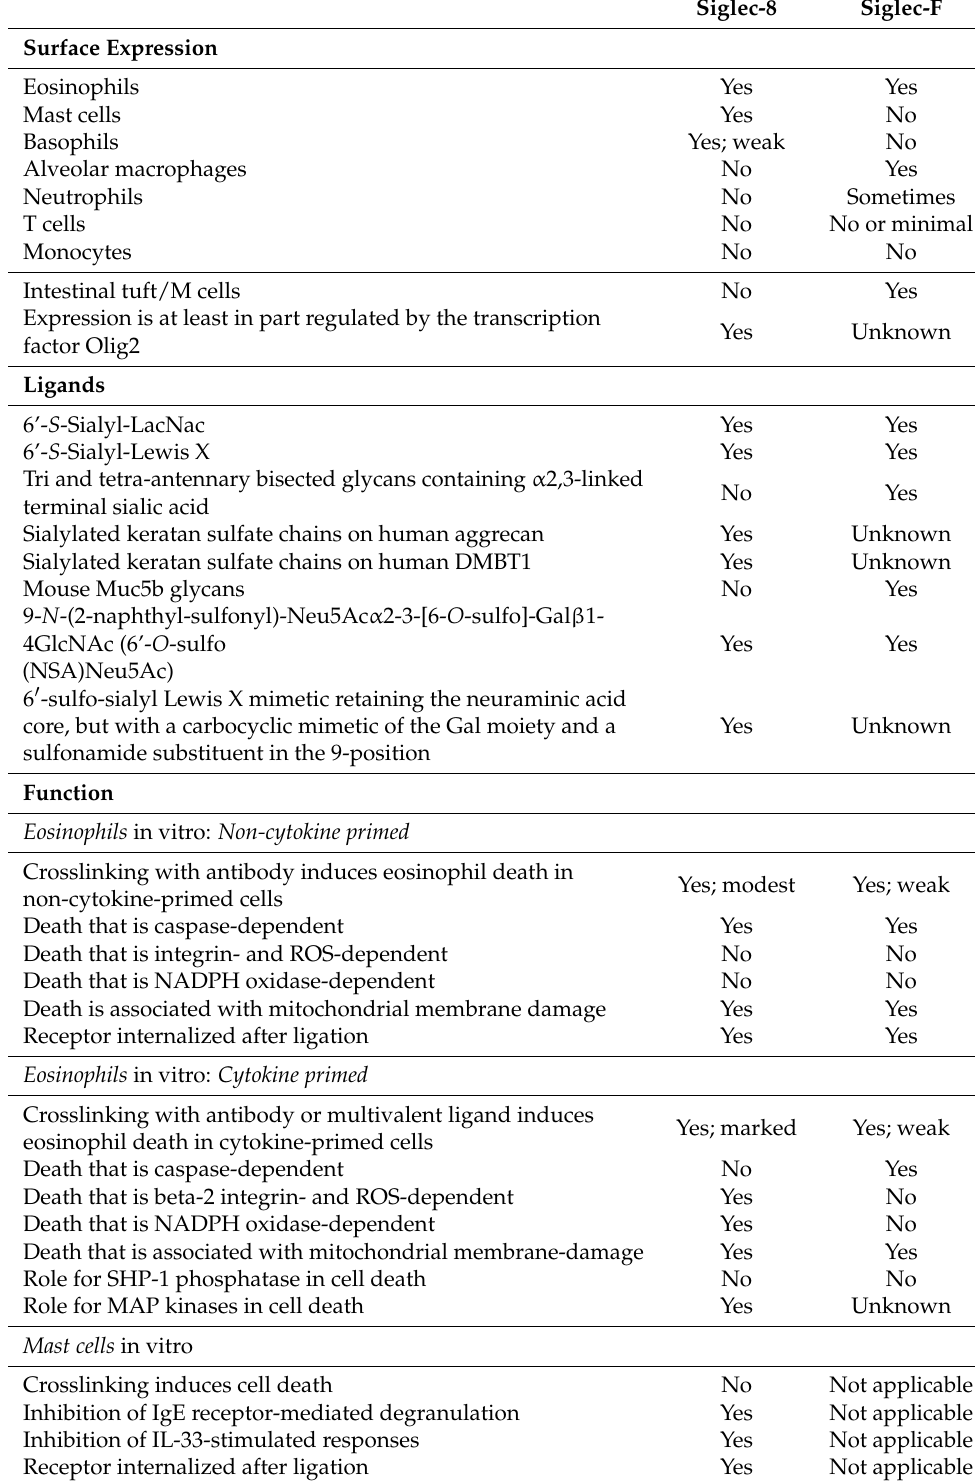
Table 1. Comparison of Siglec-8 and